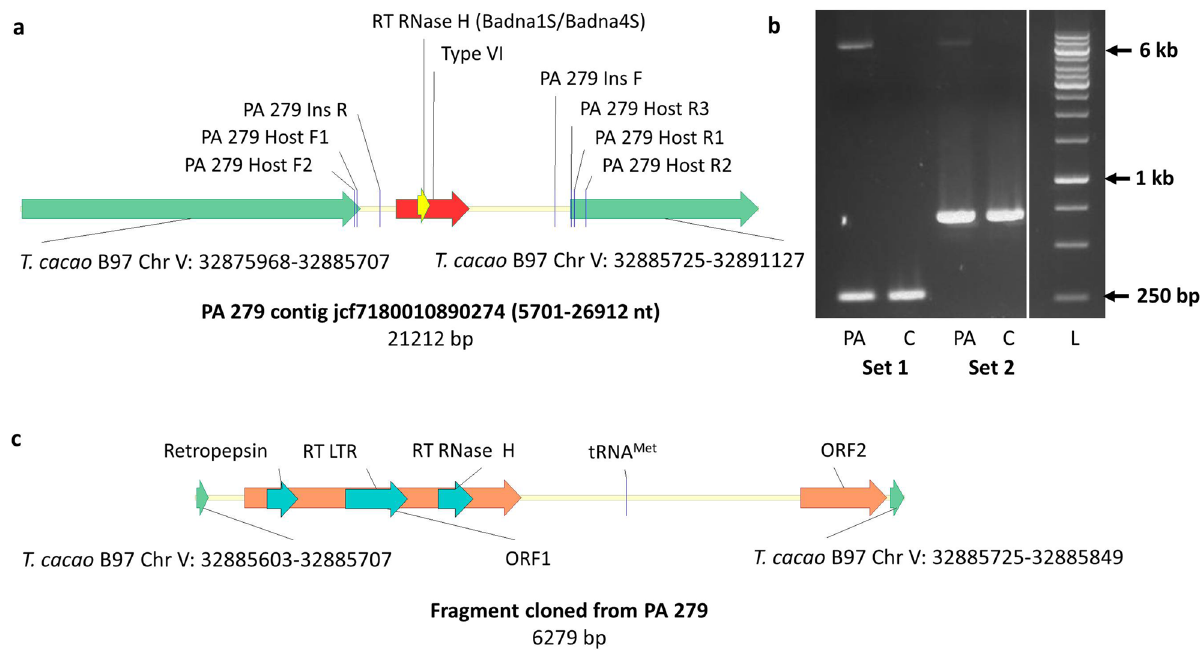
Figure 4. Amplification of type VI viral insertion from cacao clone PA 279. ( a ) Alignment of PA 279 contig jcf7180010890274 and B97 T. cacao genome Chromosome V. Green arrows represent genomic region of cacao clone B97 bordering 6050 bp of type VI viral insertion. Vertical lines indicate location of primers including primer set 1 (PA 279 Host F1, PA 279 Host R1) and set 2 (PA 279 Host F2, PA 279 Host R2) used to amplify the viral insert along with the bordering host sequence, and primers used in the multiplex assay to screen cacao germplasm for viral insertion type VI (PA 279 Host F1, PA 279 Ins R, PA 279 Ins F and PA 279 Host R3). ( b ) Amplification of the viral insert along with the bordering host sequence from PA 279 (PA) and Criollo 11 (C) clones. The 243 and 635 bp fragments amplified in both clones with primer set 1 and set 2 represent virus- allele (lacking viral insertion) whereas a fragment between 6 to 7 kb amplified in PA 279 clone in both primer sets represents virus + allele. ( c ) Open reading frames (brown arrows) and conserved domains (light blue arrows) present in the fragment amplified from PA 279 clone harbouring host genome and type VI viral sequence. Full- length gel of section ( b ) is presented in Supplementary Fig.